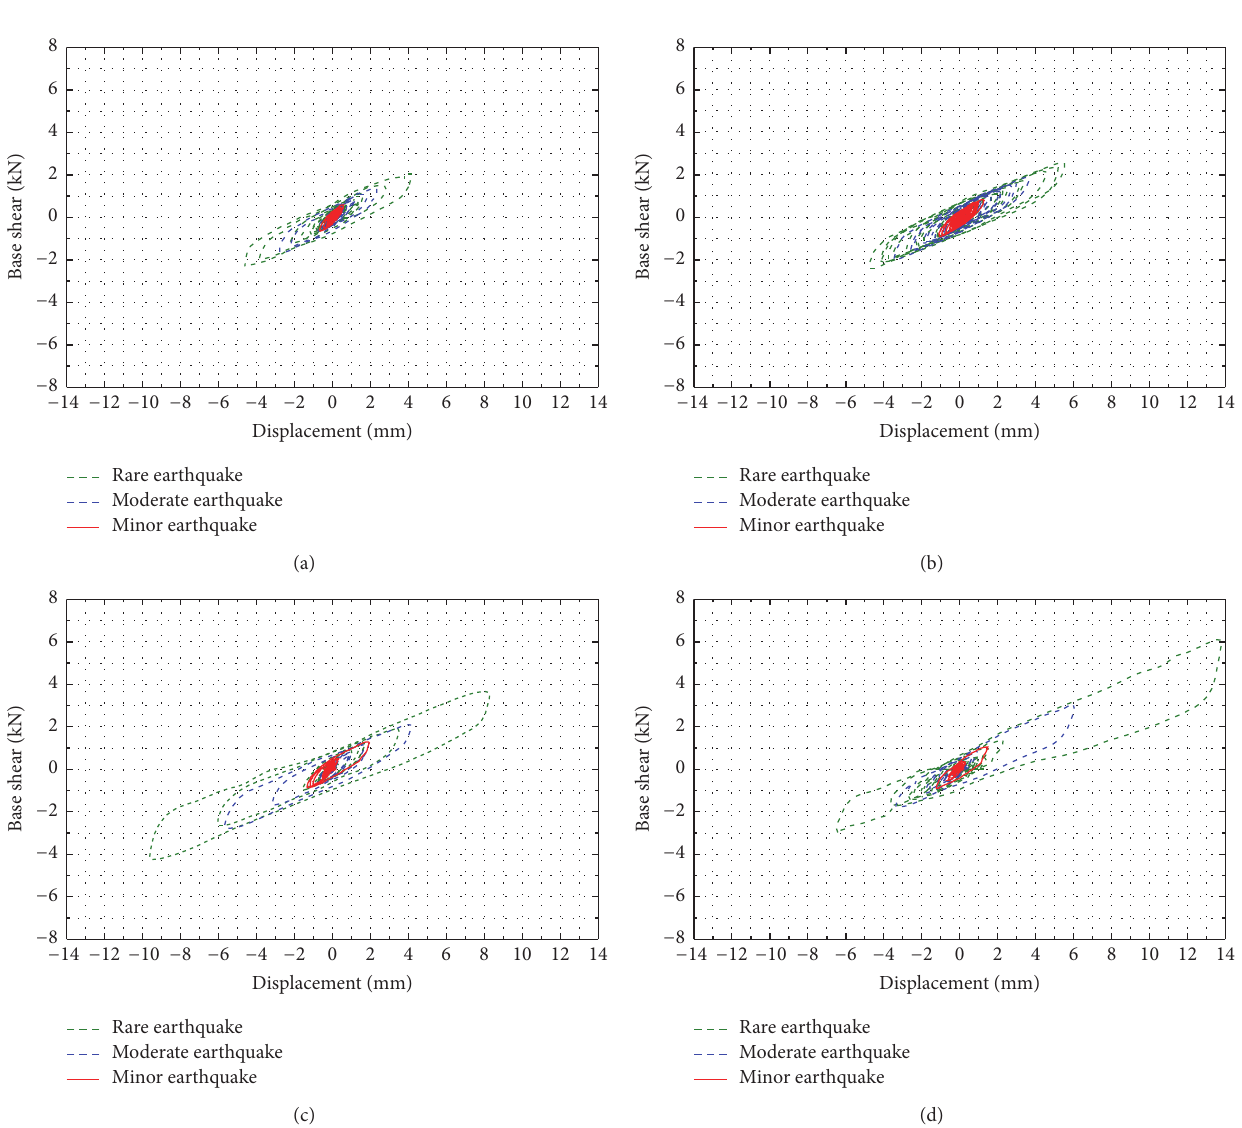
Figure 25: Typical hysteretic curves of LRB: (a) EL wave, (b) LWD wave, (c) TJ wave, and (d) ART